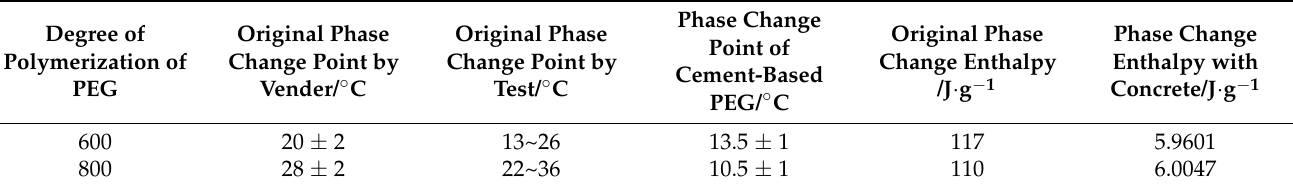
Table 7. Phase transition point of PEG cement paste with different degrees of